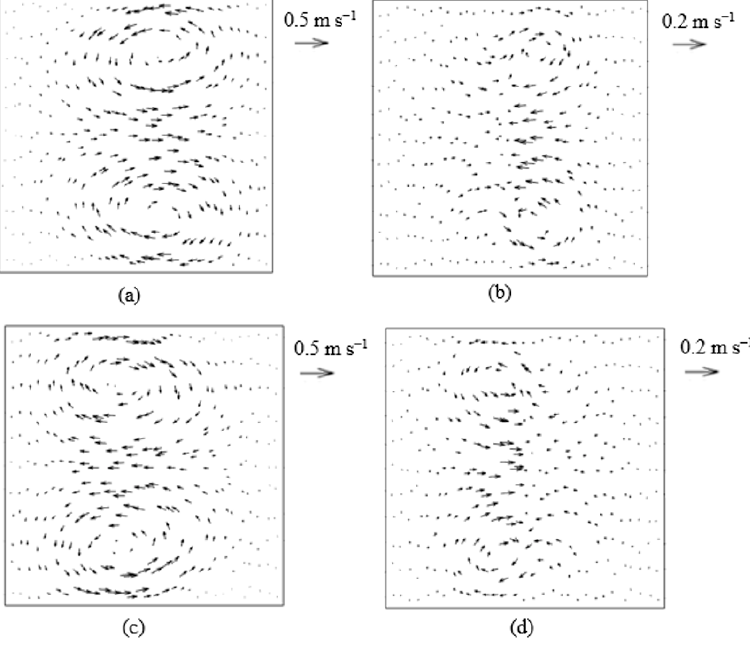
Figure 9. Velocity vectors at y = 50 mm: ( a ) Phase π /2; ( b ) Phase π ; ( c ) Phase 3 π /2; ( d ) Phase 2 π .